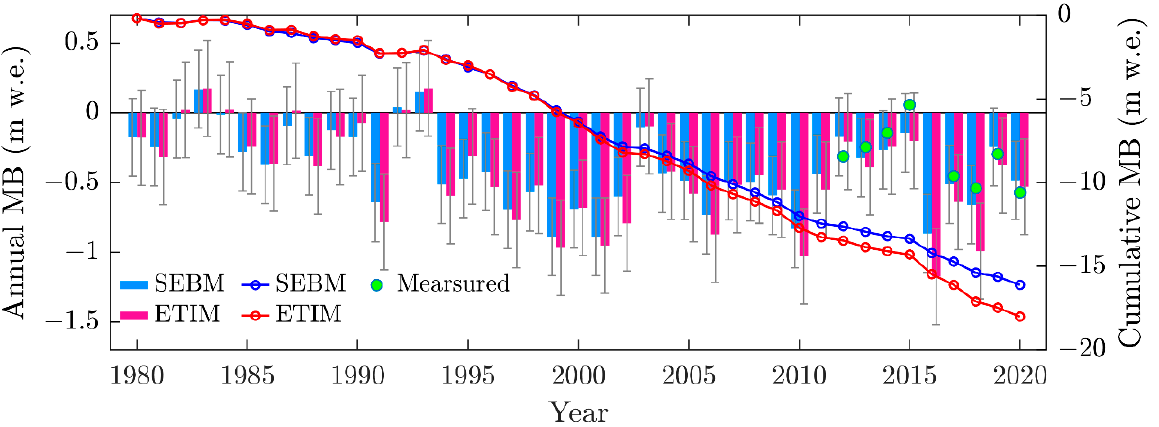
Figure 6. The measured annual MB (green dot), the modeled annual and cumulative MB by SEBM (blue) and ETIM (red).